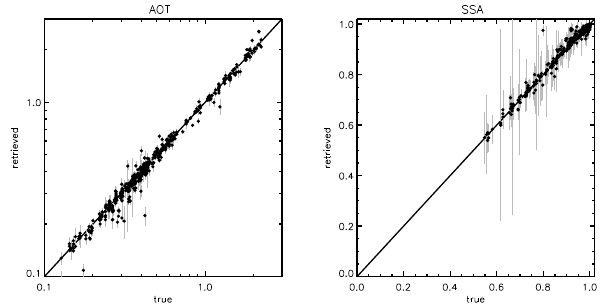
Figure 3. The true vs. retrieved AOT and SSA of those retrievals that pass the χ 2 ≤ 1 . 2 filter. The error bars indicate the SD (as ob- tained from the retrieval error covariance matrix) on the retrieved value. The black line shows the 1 : 1 ratio.